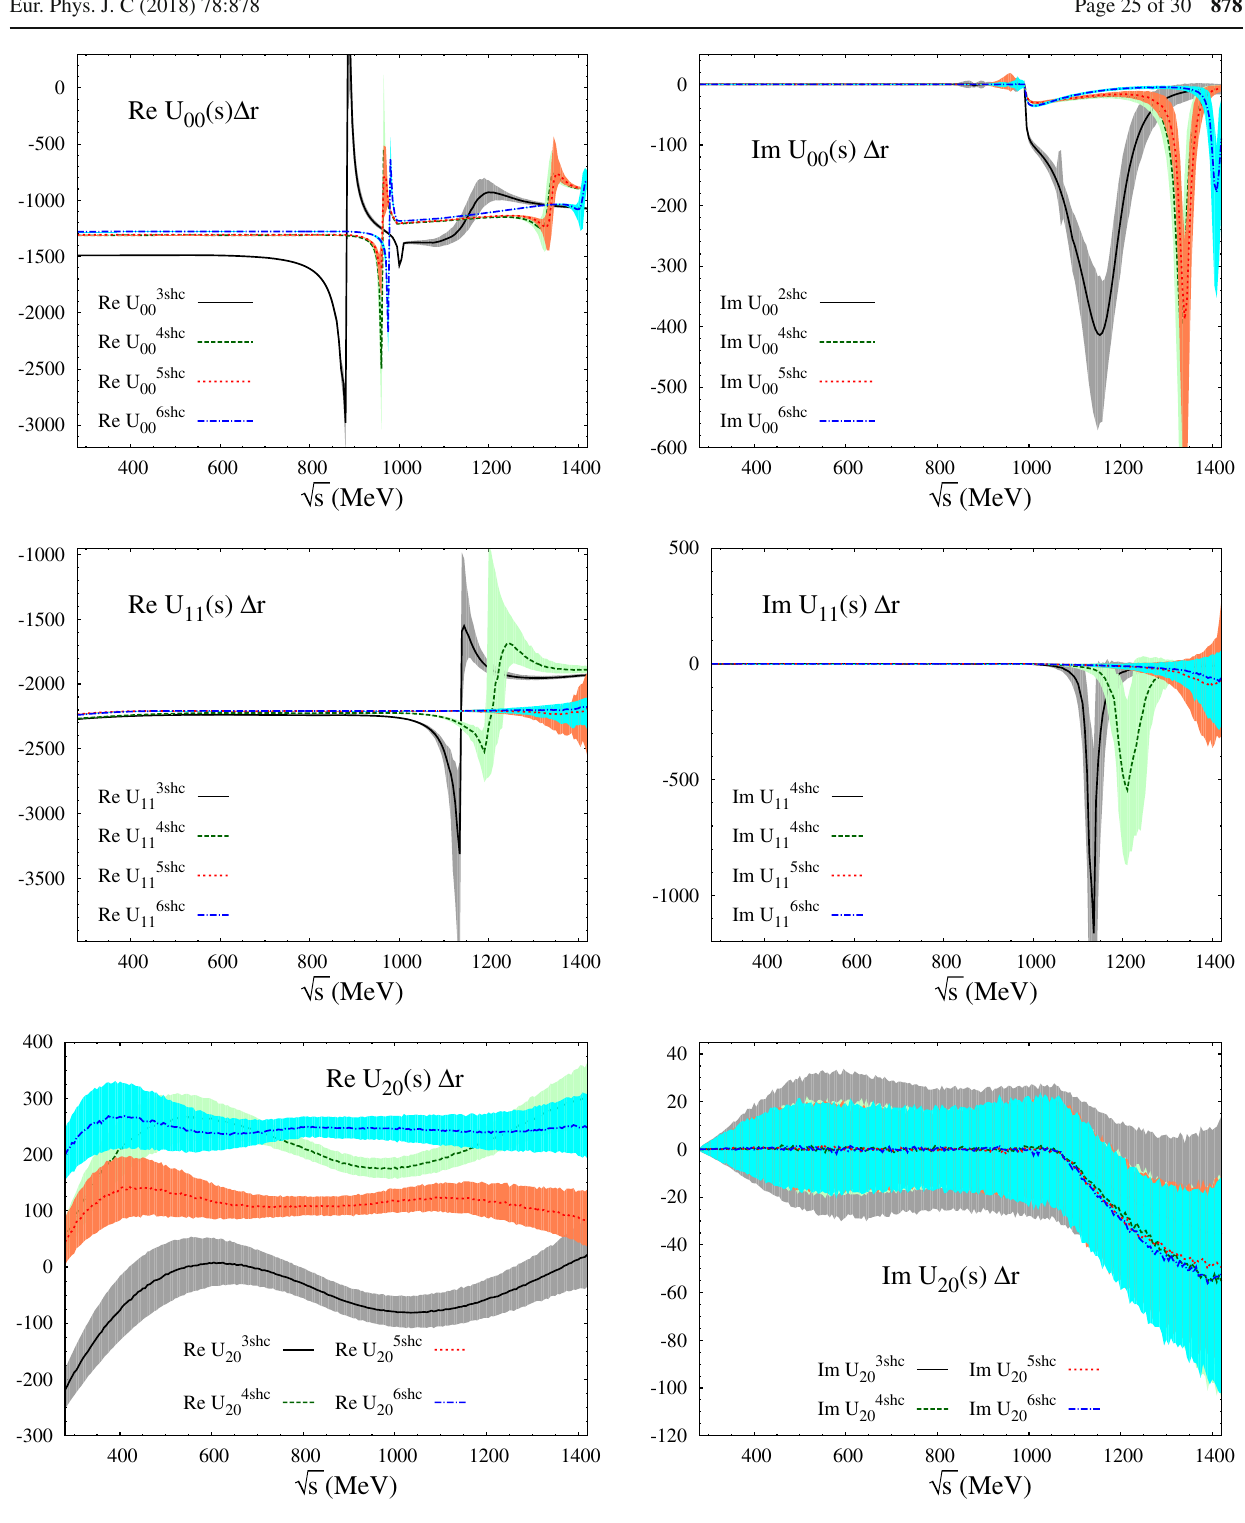
using at each energy point a bootstrap with a uniformly distributed sample of 1000 points and taking the 68% of their distribution as the standard